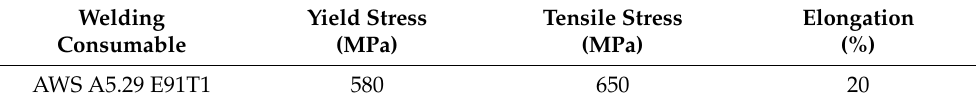
Table 5. Welding conditions used. Process